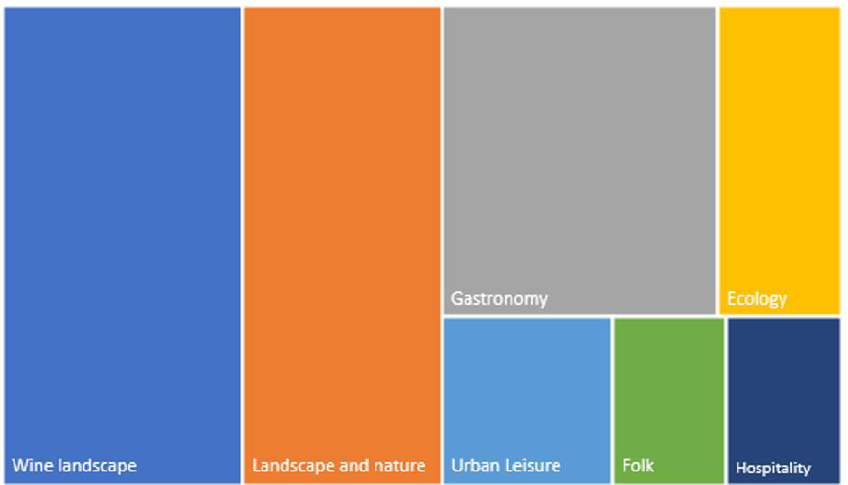
Figure 9. Tourist attractions of the Lanzarote AO. Source: Own elaboration.